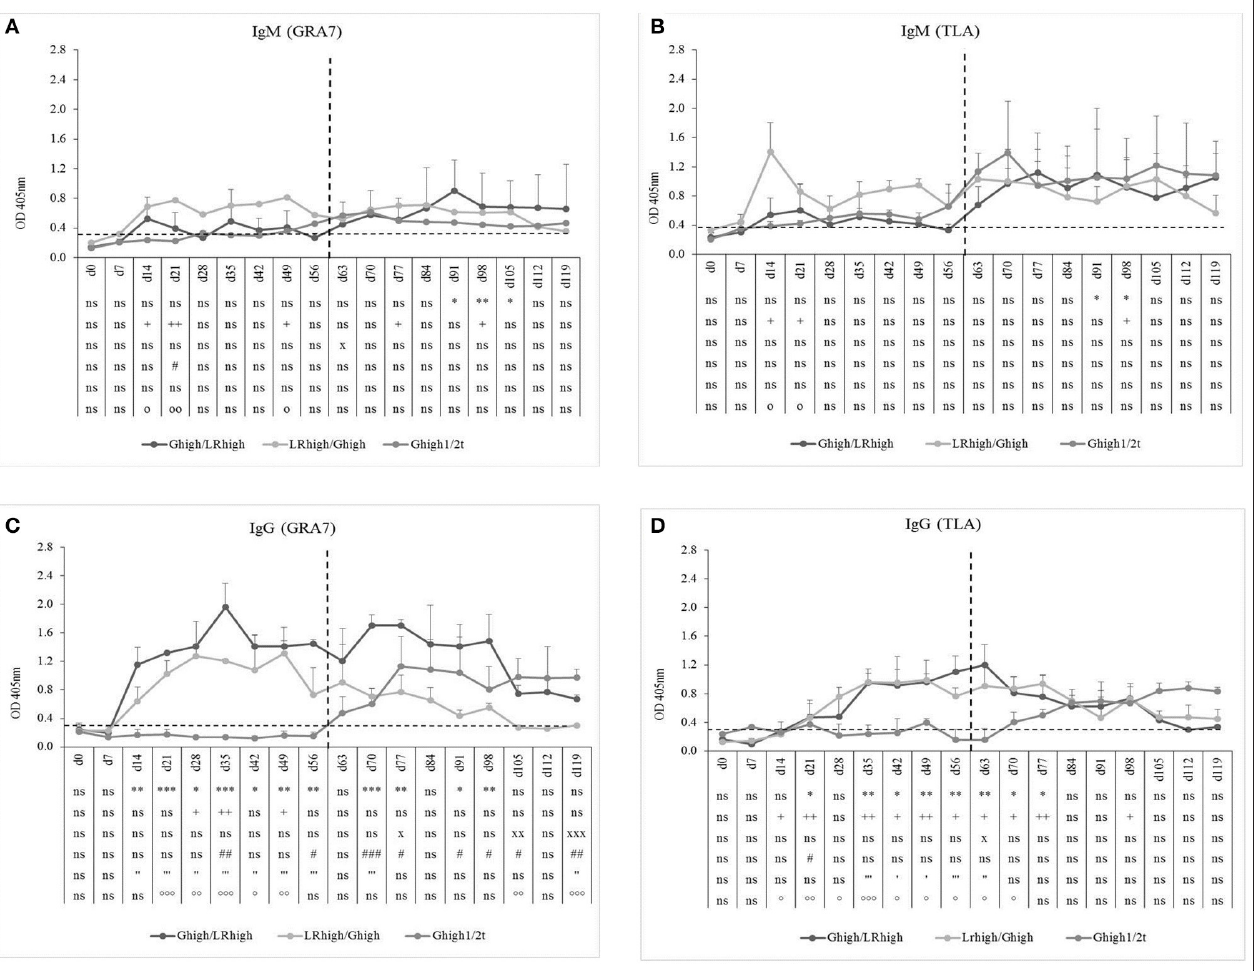
FIGURE 5 | GRA7- and TLA-specific IgM and IgG responses after inoculation with IPB-G and IPB-LR T. gondii strains. IgM (A,B) and IgG (C,D) antibody response toward T. gondii GRA7 (A,C) and TLA (B,D) in animals after a consecutive infection with a high dose of IPB-G and IPB-LR strains. Groups: G high /LR high , LR high /G high . Piglets infected after 60 days with a high dose IPB-G served as a control (G high1 / 2t ). The horizonthal dashed line indicates the cut-off value based on the mean of the negative animals, and the vertical one the timepoint of reinfection.The results represent a mean of the infected group ± SD; * G high /LR high vs. controls, + LR high /G high vs. controls, x G high1 / 2t vs. controls, # G high /LR high vs. LR high /G high , ’ G high /LR high vs. G high1 / 2t , ◦ LR high /G high vs. G high1 / 2t : P < 0.05, ** or ++ or xx or ## or “ or ◦◦ : P < 0.01; *** or xxx or ### or ”’ or ◦◦◦ ; P < 0.001; ns, not